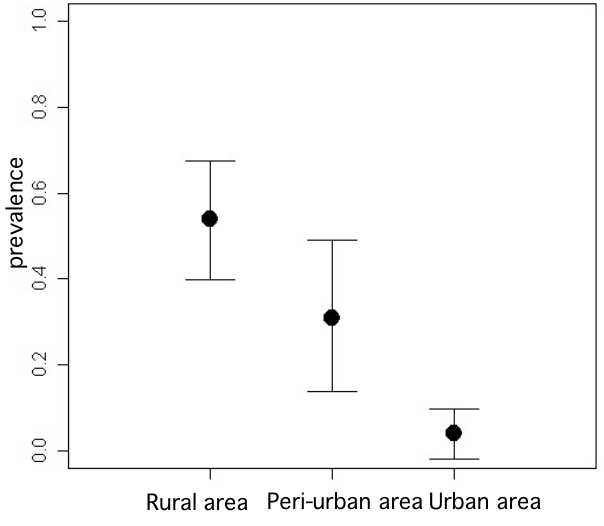
Fig. 2. – Prevalence of Echinococcus multilocularis in red foxes according to urbanisation level. Lines represent 95 % confidence inter- than 1,000, with the highest score of 135,565 in one